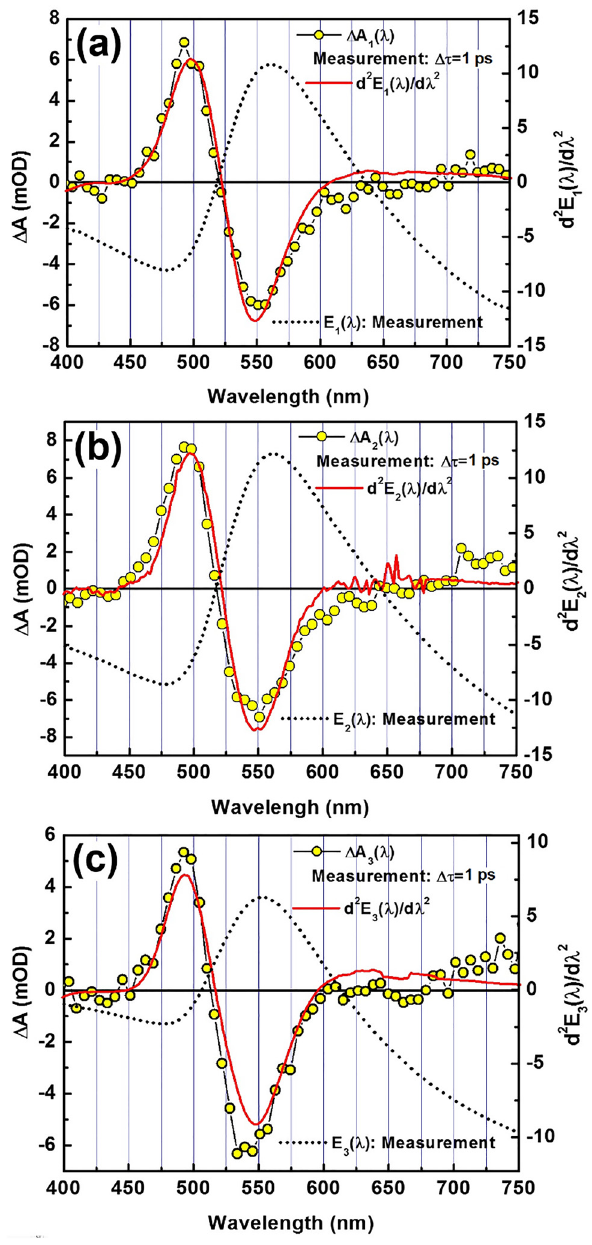
Figure 3: Measured transient absorption spectra (filled circles, Δ A ) and calculated second-order differentials (solid red, d 2 E ( λ )/d λ 2 ) of theopticalextinctionspectra(dottedblack, E ( λ ))forsamples A (a), B (b), and C (c),